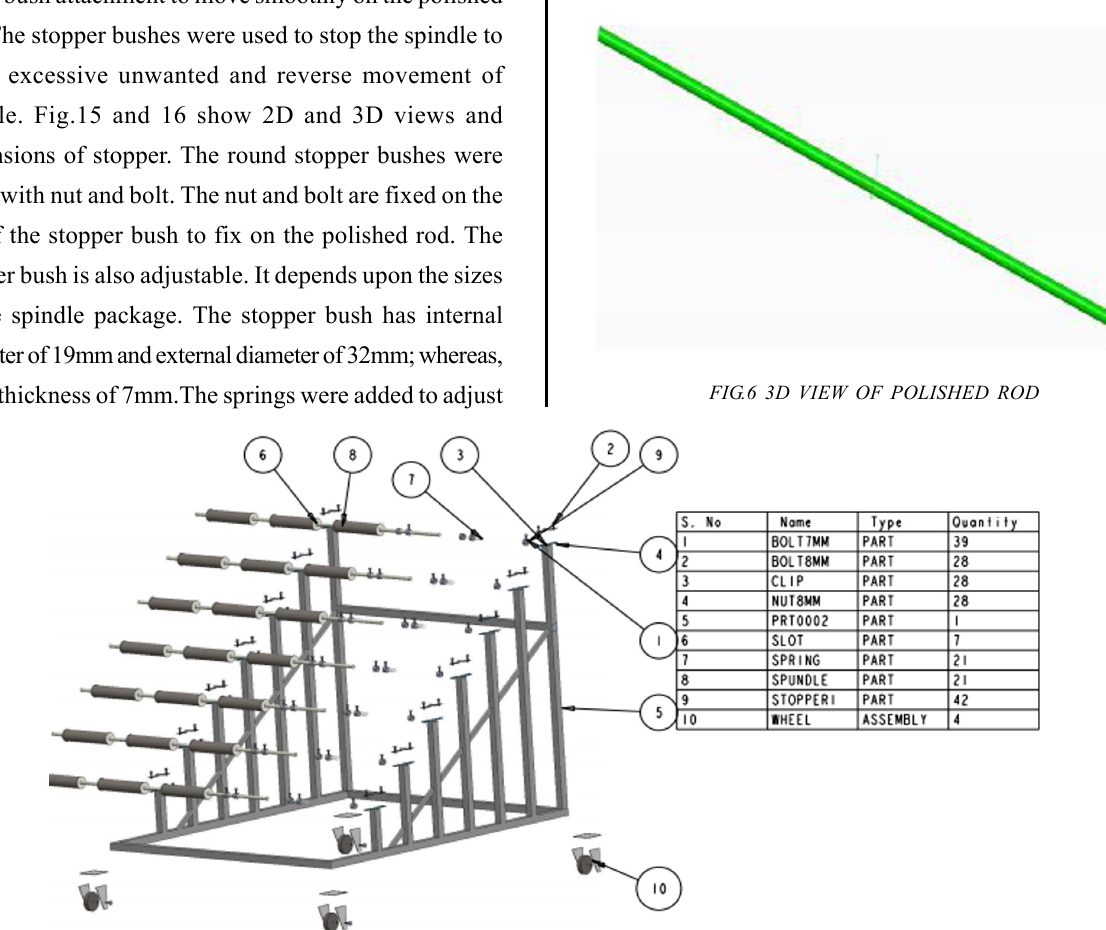
FIG.5 2D VIEW OF POLISHED ROD